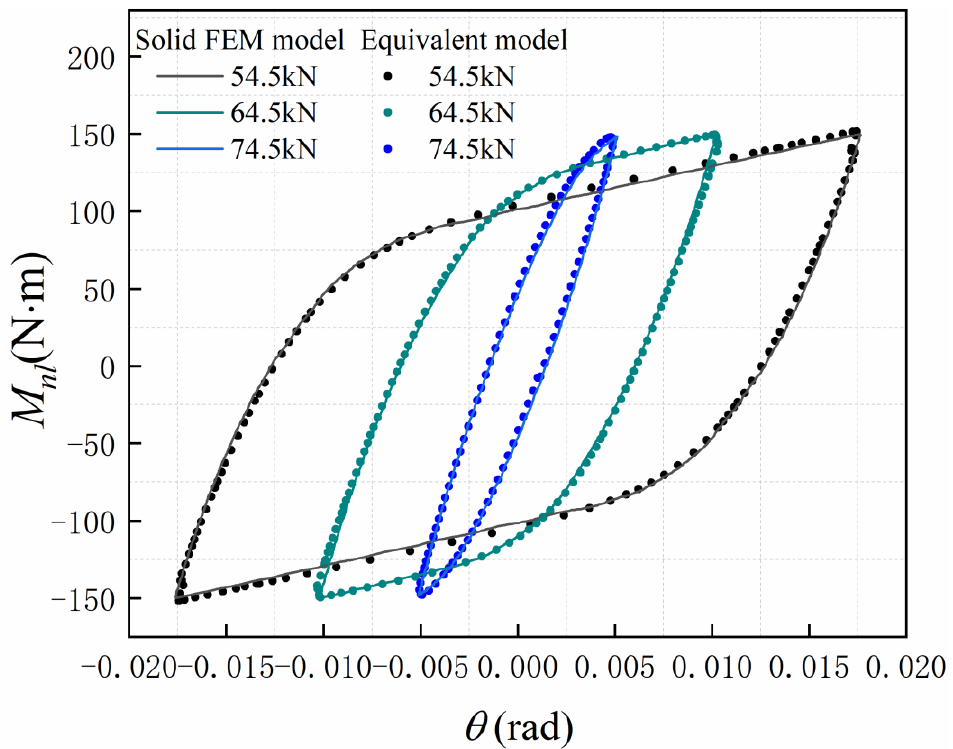
Figure 20. Responses of the equivalent model and the solid FEM model under different preload levels, F 0 = 500 N, ω = 30 rad/s.